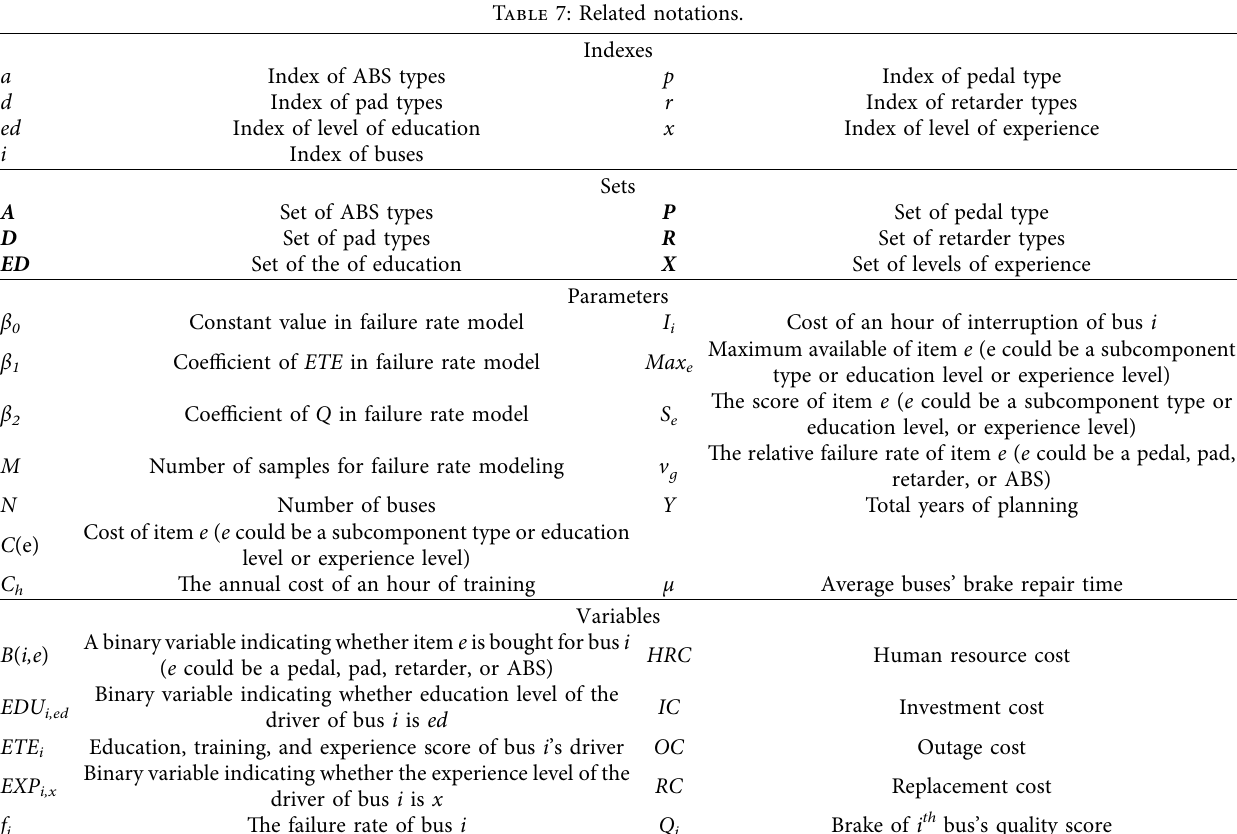
Table 7: Related